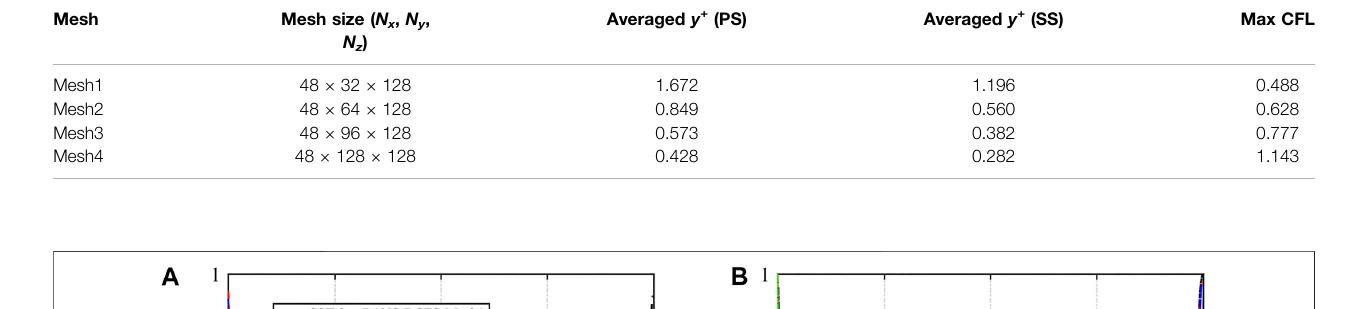
TABLE 1 | Parameters of grid convergence for rotating channel fl ow at Ro = 0.6. Mesh